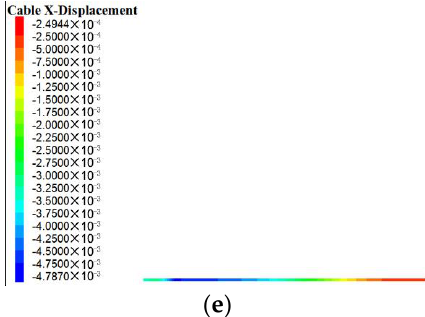
Figure 13. Cloud image of the cable displacement under different bond stiffness (with a fracture aperture of 4 mm). ( a ) Bond stiffness = 0.6 GPa; ( b ) bond stiffness = 0.8 GPa; ( c ) bond stiffness = 1.0 GPa; ( d ) bond stiffness = 1.2 GPa; ( e ) bond stiffness = 1.4 GPa.